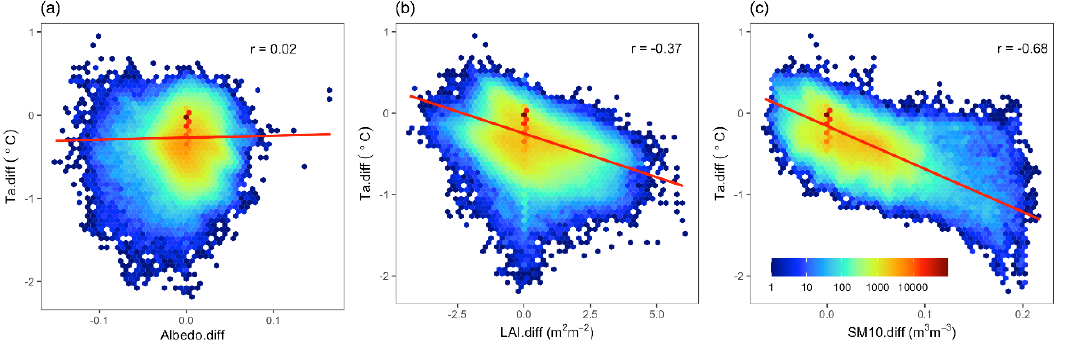
Figure 11. Density scatter diagram of ( a ) albedo difference, ( b ) LAI difference, and ( c ) 10 cm soil moisture difference, and corresponding air-temperature difference.